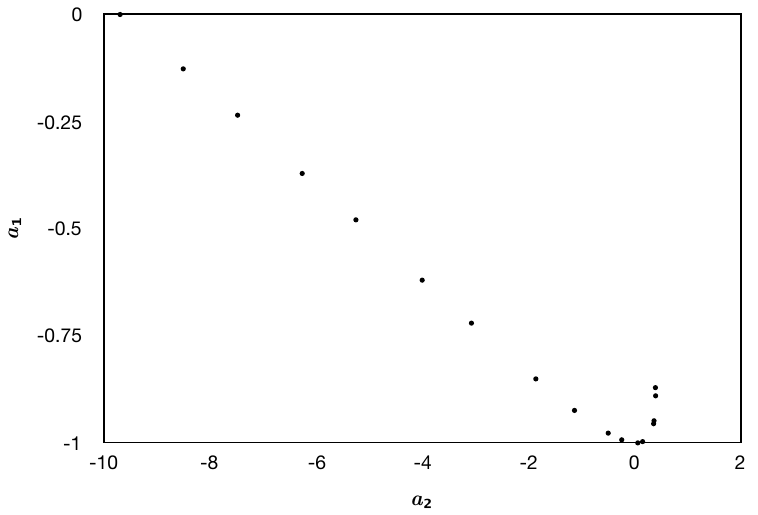
Figure 3. Numerically computed curve in the parameter space of a 1 and a 2 that corresponds to (cid:12)xing the periodicity of (cid:31) to be 4 (cid:25)= 3, which agrees with the AdS soliton with M = 1. Corresponding curves for other periodicities can be easily obtained using the scaling symmetry (2.13). Since the energy is proportional to a 1 , this shows that it is minimized at the AdS